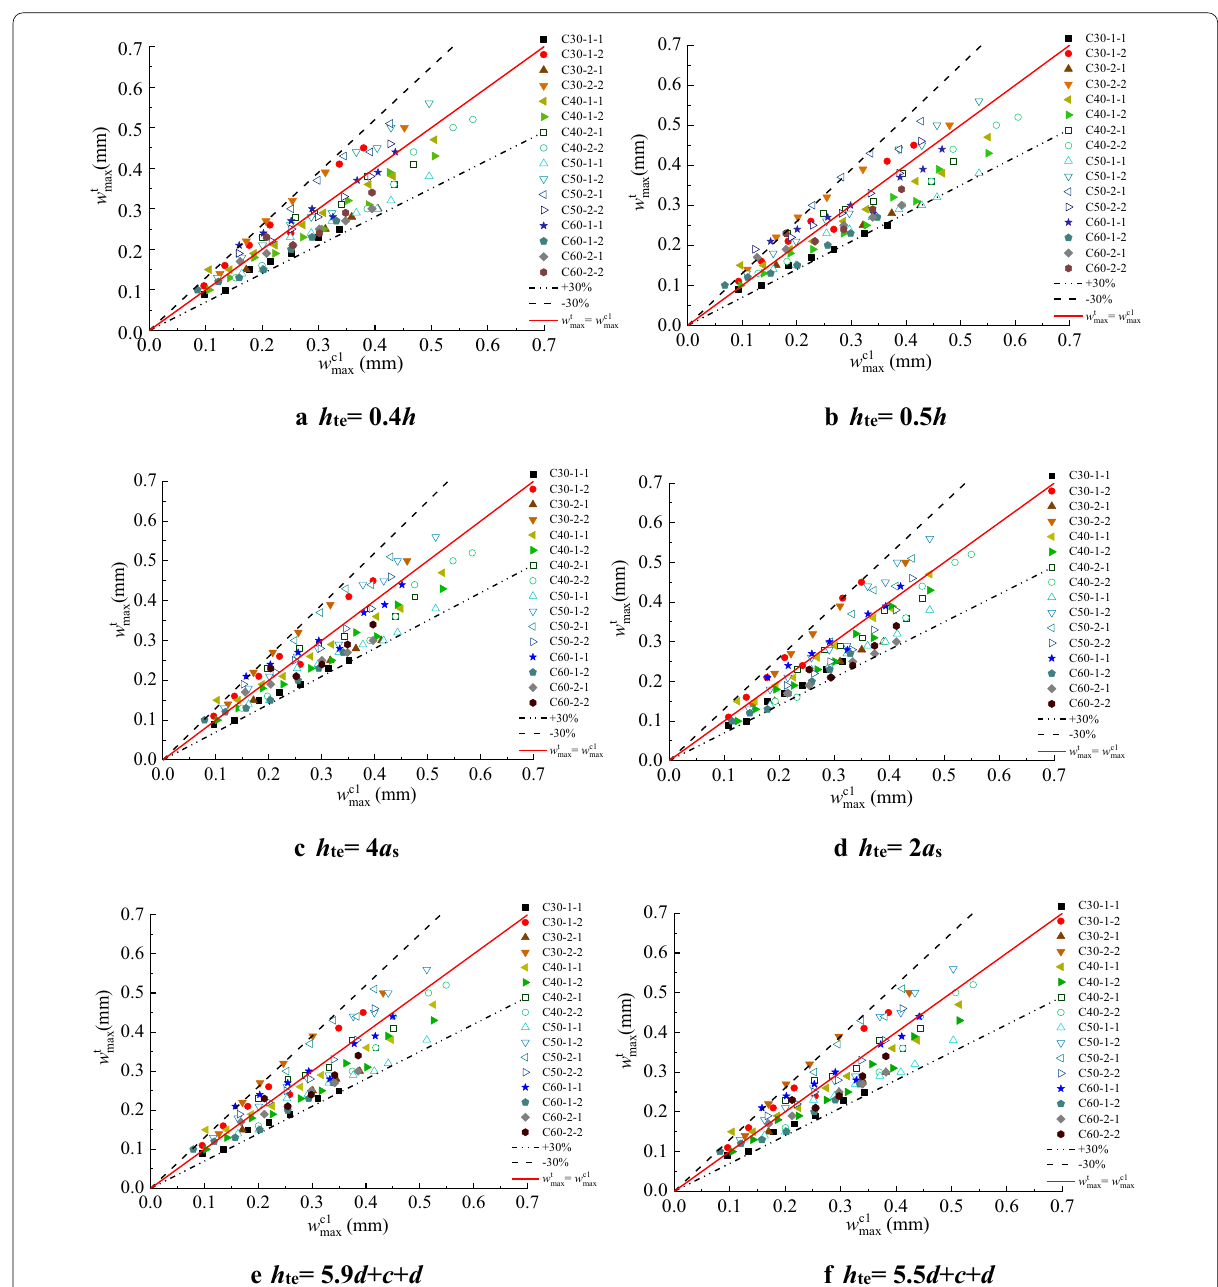
Fig. 18 Comparison of experimental w t max from RC beams with 600 MPa steel bars with calculated w c1 max by the proposed